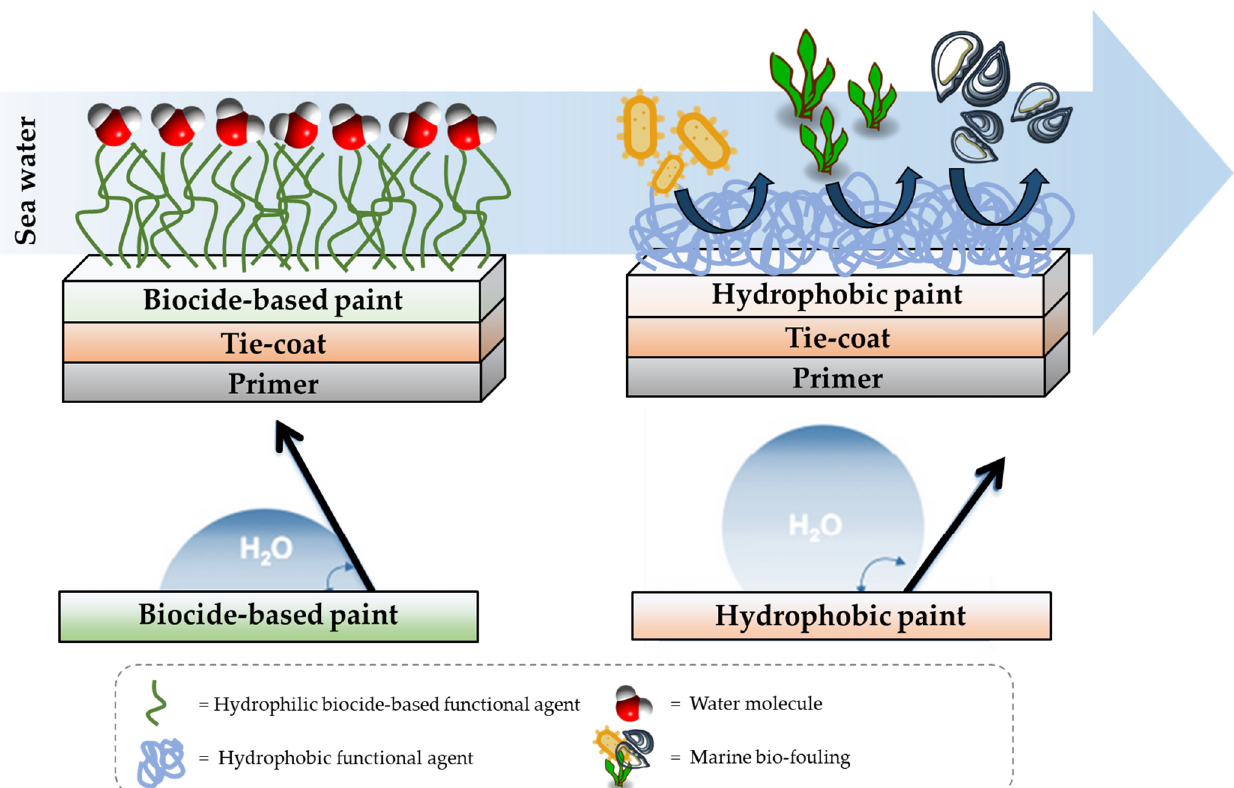
Figure 1. Anti-Fouling and Fouling Release activity of biocide-based and hydrophobic coatings, re- spectively.